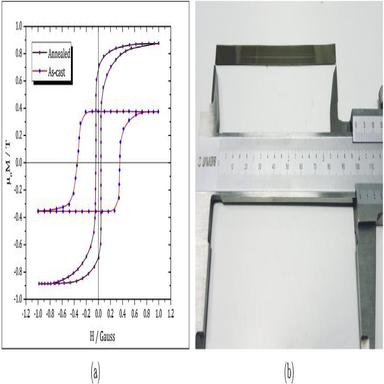
(a) Metglas 2826MB ribbon hysteresis loops, (b) Metglas ribbon as it has been prepared for characterization (Length = 100 mm).